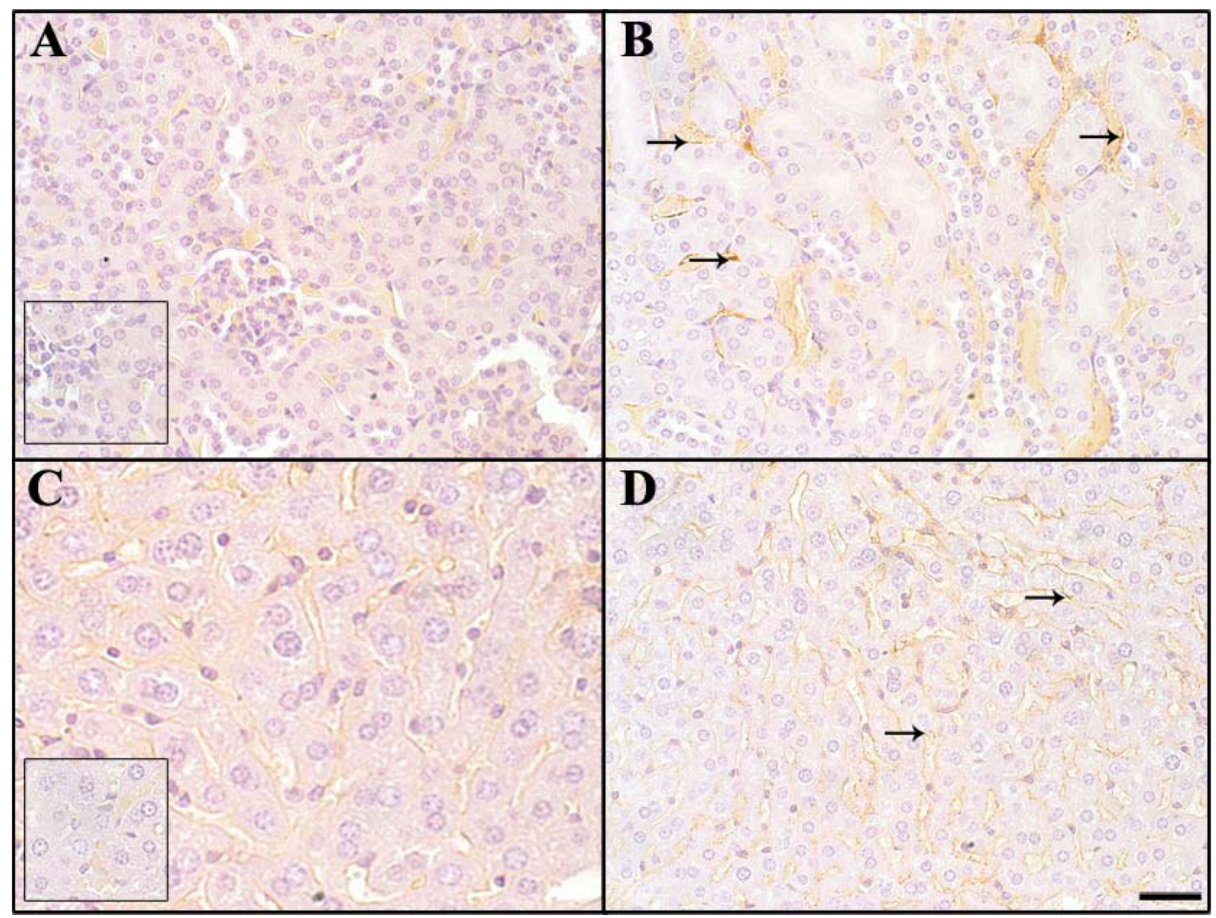
Figure 6. Comparison of IgG and IgM binding of tissues of non-immunized mice. Normal tissues were immunostained with antibody against naturally deposited murine IgG ( A,C ) and IgM ( B,D ). IgM staining is more intense, with a membranous and punctate pattern on endothelial cells (arrows). No staining is present in negative controls labeled with goat immunoglobulin ( inset A and inset C ). Kidney ( A,B ) and liver ( C,D ), 400× magnification, bar equals 40 μ